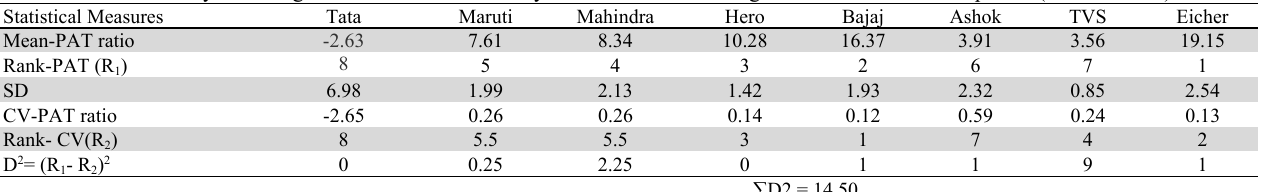
Relational Co-variability of average PAT ratio and variability of PAT ratio of leading Indian automobile companies (2011 to 2020) Statistical Measures Tata Maruti Mahindra Hero Bajaj Ashok TVS -2.63